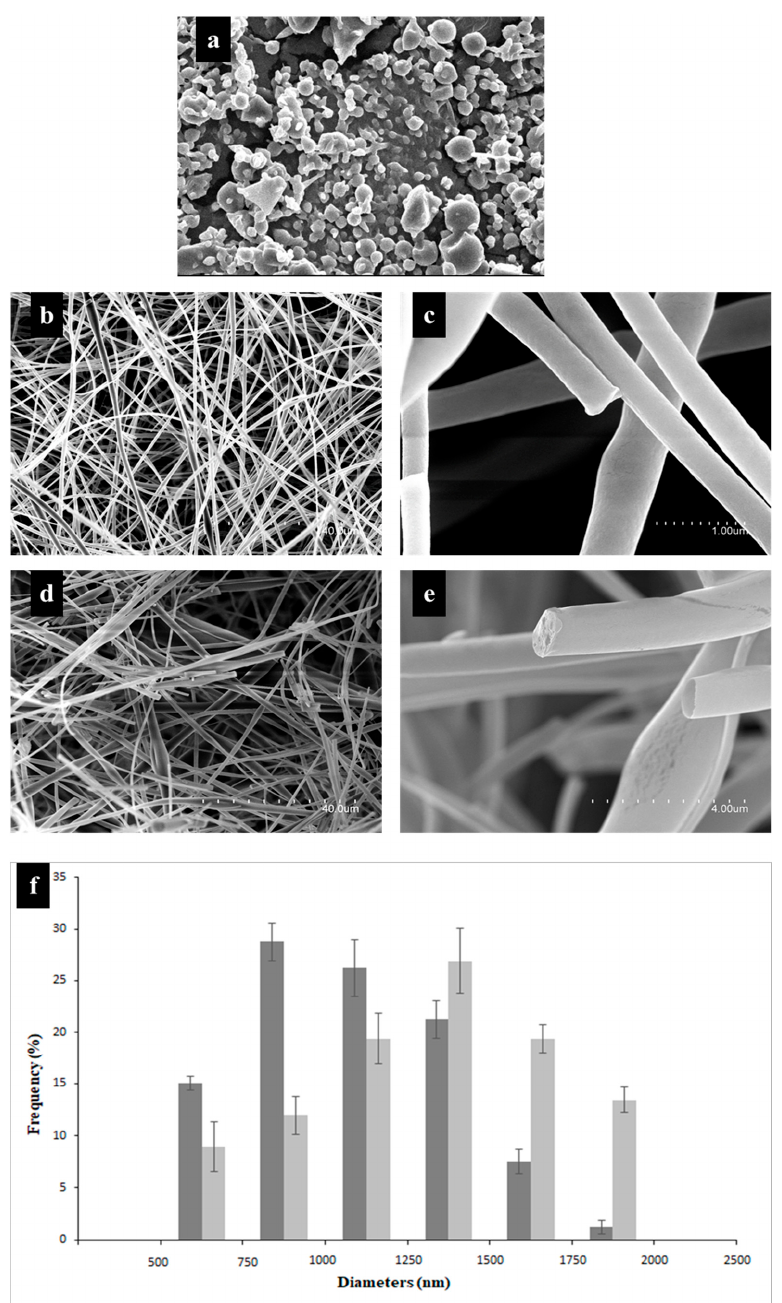
Figure 1. Scanning electron microscopy (SEM) micrographs show structures obtained with ( a ) 60% HDPAF, ( b , c ) fibers obtained with 70% HDPAF without β -carotene at different magnification, ( d , e ) fibers obtained with 70% HDPAF loaded with β -carotene at different magnification, ( f ) distribution of micro-nanofiber diameters obtained with the 70% HDPAF formulation ( ▄ ) without and ( ▄ ) with β -carotene. The average values and standard deviation (SD) were obtained from the analysis of three